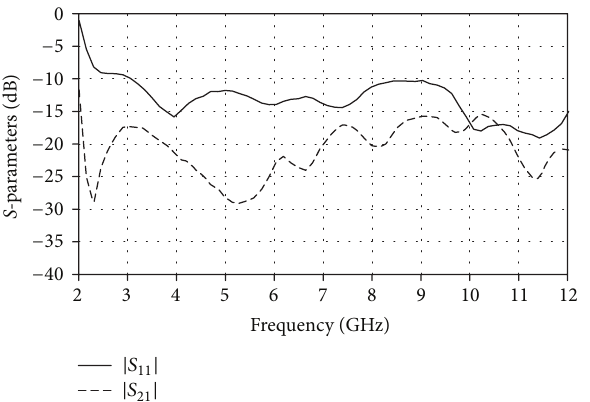
Figure 4: Measured reflection coefficient |𝑆 11 | and isolation |𝑆 21 | against frequency of the proposed